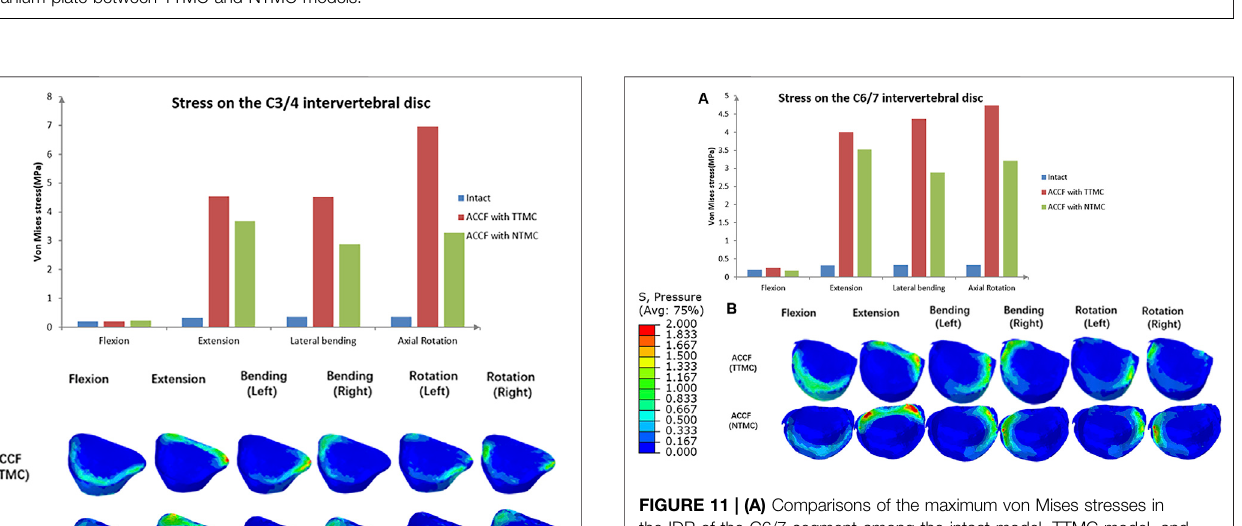
FIGURE 9 | (A) Comparisons of the maximum von Mises stresses of the fi xation systems between TTMC and NTMC models; (B) Stress cloud map of the anterior titanium plate between TTMC and NTMC models.